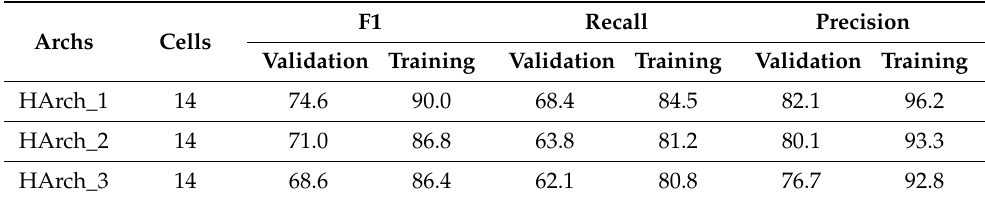
Table 2. Applying Darts directly for ship detection on